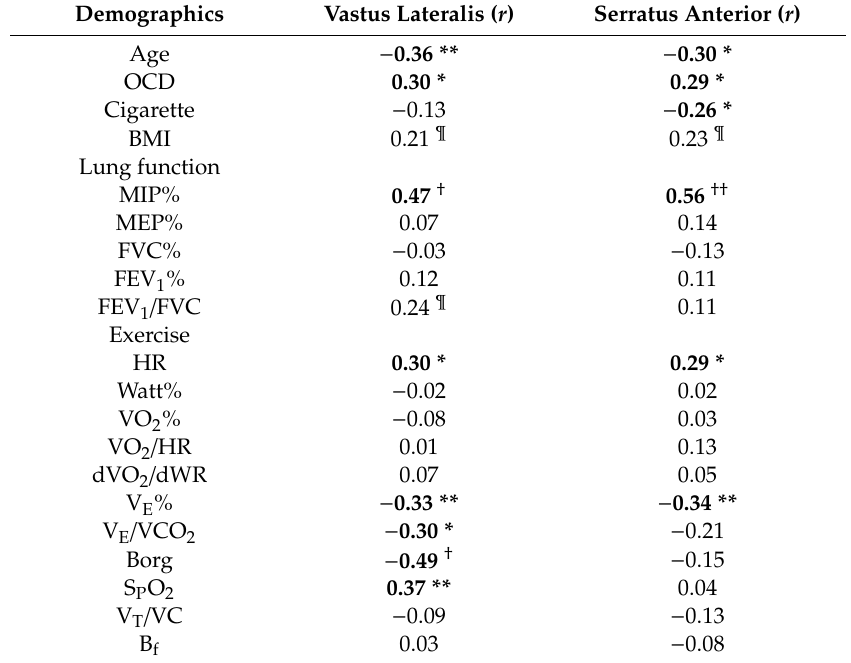
Table 3. Correlation coe ffi cient ( r ) of oxygenation saturation of muscles at peak exercise with demographics, lung function and peak / nadir exercise in all subjects. Demographics Vastus Lateralis ( r ) Serratus Anterior ( r ) Age − 0.36